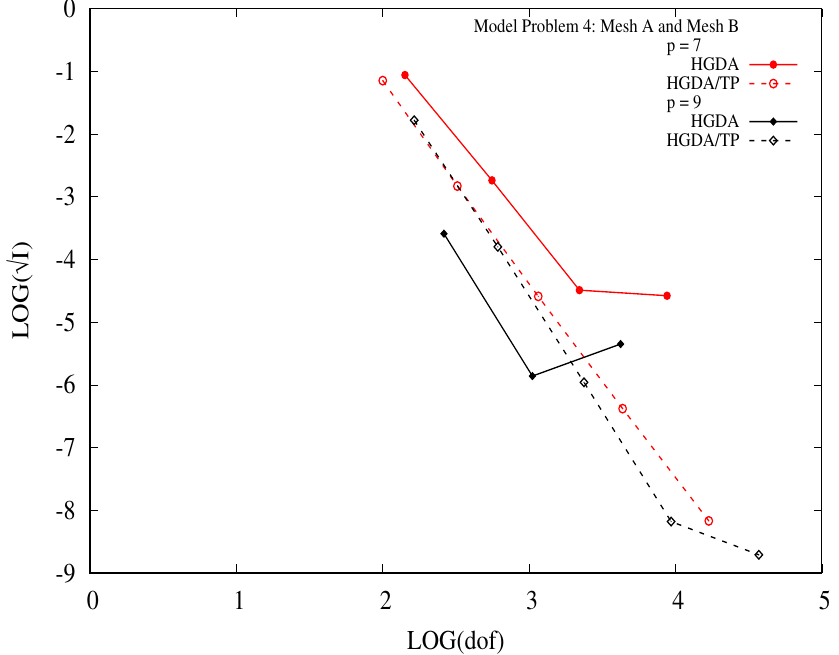
Figure 21. Residual function I versus dof, C 33 solutions: Model Problem 4 (Poisson’s Equation; Mesh B, HGDA/DG; Mesh A,